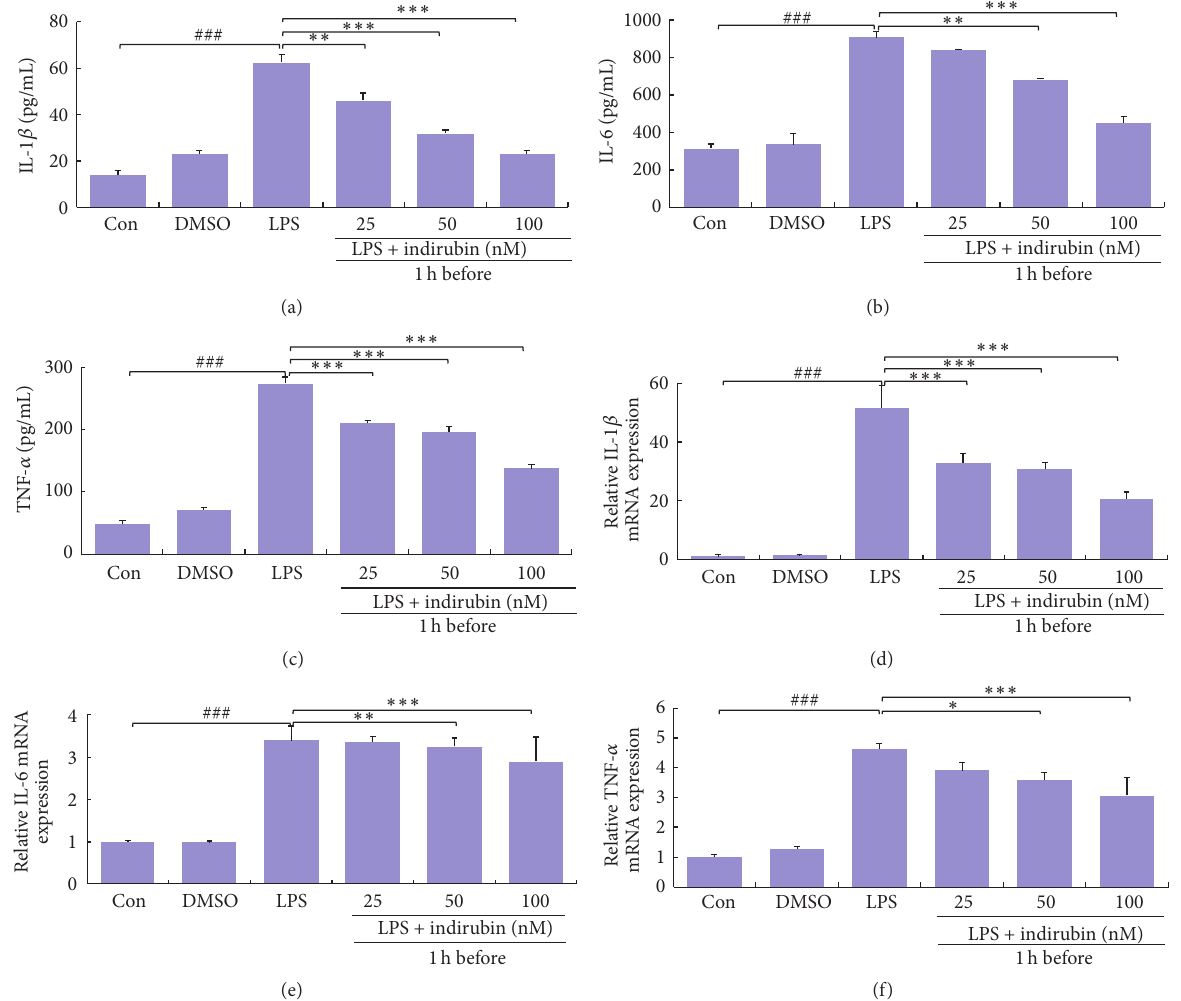
Figure 4: Effects of indirubin on secretion of IL-1 𝛽 , IL-6, and TNF- 𝛼 by LPS-stimulated MMECs. The expressions for IL-1 𝛽 (a, d), IL-6 (b, e), and TNF- 𝛼 (c, f) were measured by ELISA (a–c) and qRT-PCR (d–f). Data are presented as means ± SEM ( 𝑛 = 3 ). ### 𝑝 < 0.001 versus control group; ∗ 𝑝 < 0.05 , ∗∗ 𝑝 < 0.01 , and ∗∗∗ 𝑝 < 0.001 versus LPS